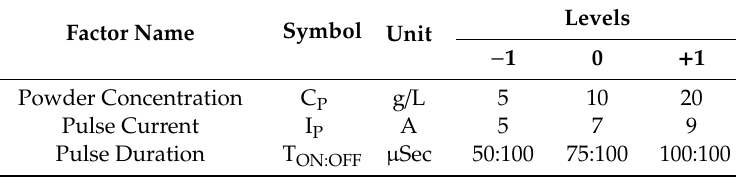
Figure 2. Schematic of process ( a ) EDM; ( b ) PMEDM. Table 4. List of variable control parameters and their values.